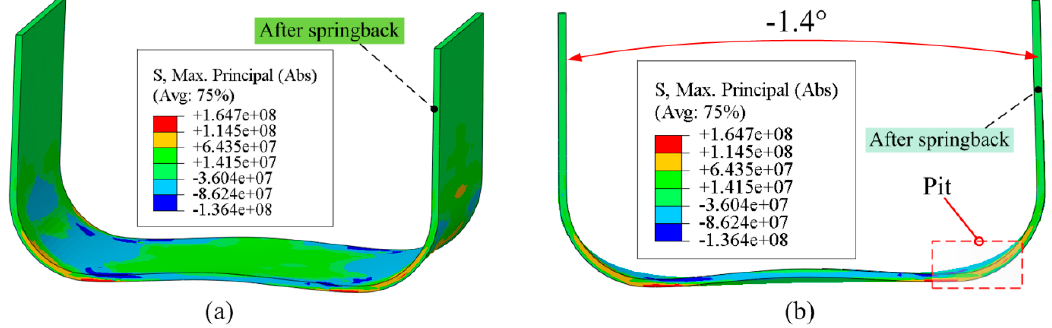
Figure 12. Springback after coil discharge at 3 kV: ( a ) 3D view; ( b ) 2D view.